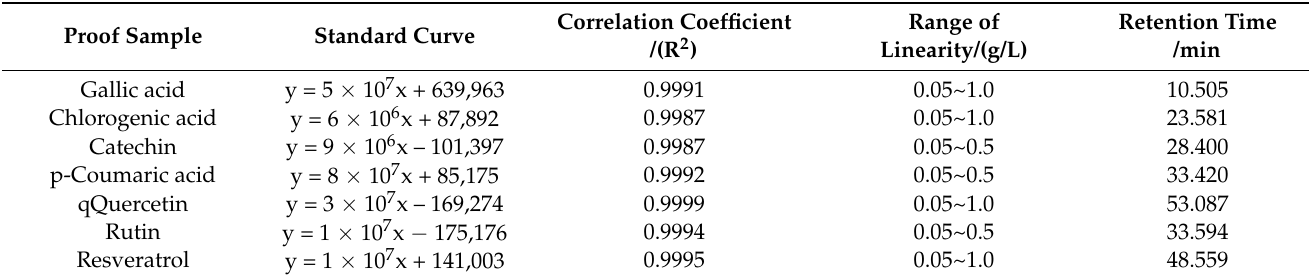
Figure 7. HPLC pictures of 7 polyphenol standards and polyphenol compounds in different parts of Pleioblastus amarus (Keng) shell: 1. Gallic acid, 2. Chlorogenic, 3. Catechin, 4. Rutin, 5. P-Coumaric acid, 6. Resveratrol, and 7. Quercetin. Table 8. HPLC profile information of 7 phenolic substances. Table 8. HPLC profile information of 7 phenolic